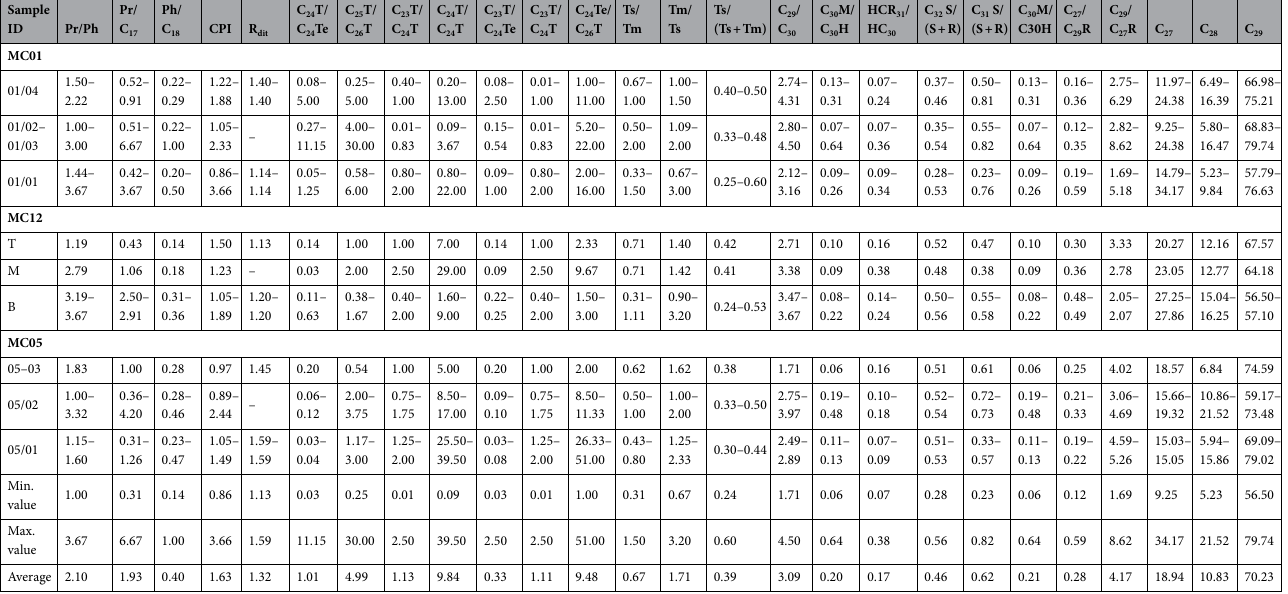
Table 3. Molecular composition of the studied coal. compound numbers are stated in Appendix I. Pr: pristane; Ph: phytane; CPI: carbon preference index (1): {2(C 23 + C 25 + C 27 + C 29 )/(C 22 + 2[C 24 + C 26 + C 28 ] + C 30 )}; R dit : (19-norisopimarane + isopimarane + 16α-kaurane)/(ent-beyerane + 16β-phyllocladane + 16α-phyllocladane); C 24 T/C 24 Te: C 24 Tricyclic/C 24 Tetracyclic; Ts: (C 27 18α(H)-22,29,30-trisnorneohopane); Tm: (C 27 17α(H)- 22,29,30-trisnorhopane); C 29 /C 30 : C 29 norhopane/C 30 hopane; HCR 31 /HC 30 : C 31 regular homohopane/C 30 hopane; C 31 S/(S + R): C 31 Homohopane 22S/(22S + 22R); C 32 S/(S + R) = C 31 Homohopane 22S/(22S + 22R); C 29 / C 27 R = Regular steranes C 29 /C 27